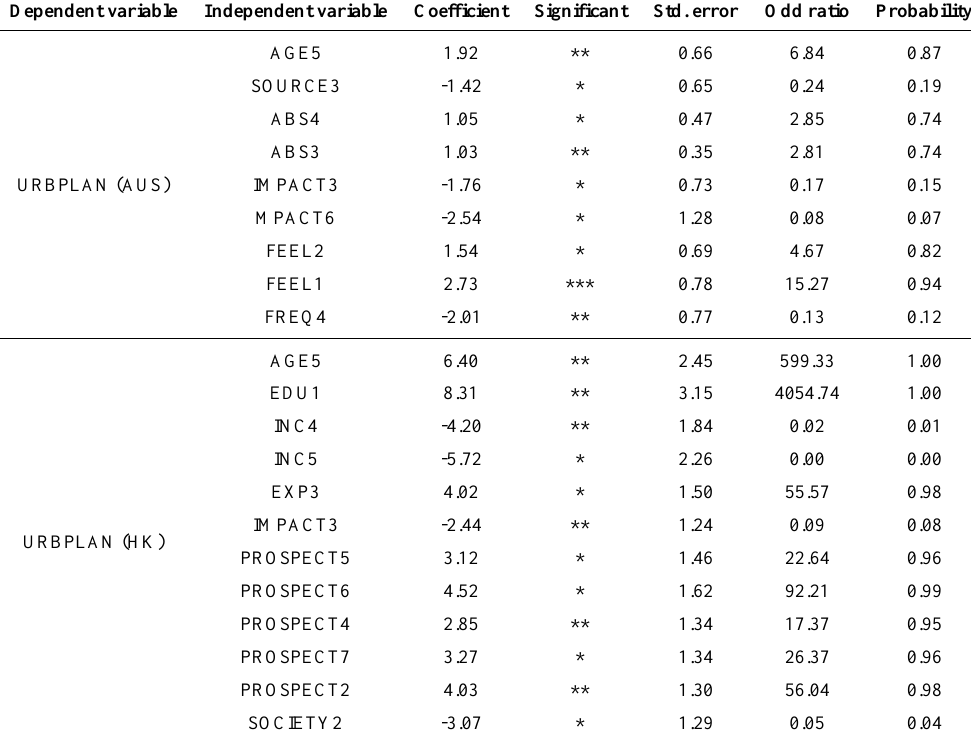
Table A-18. Urban planning and development